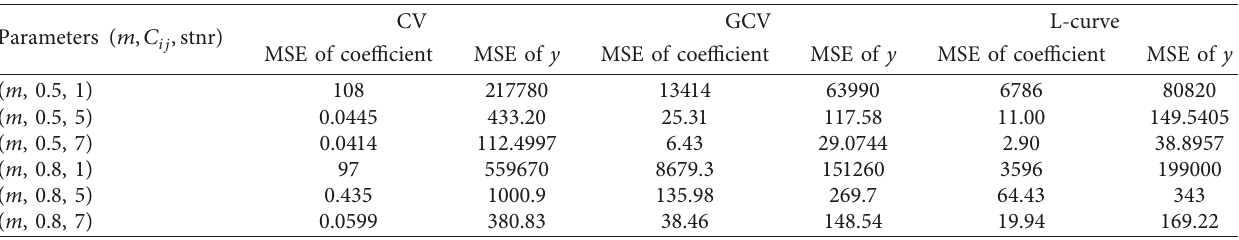
Table 4: The result of the comparison between cross validation (CV), generalized cross validation (GCV), and L-curve criterion in PLS regression in terms of mean squared error of both the estimator and the predicted y .